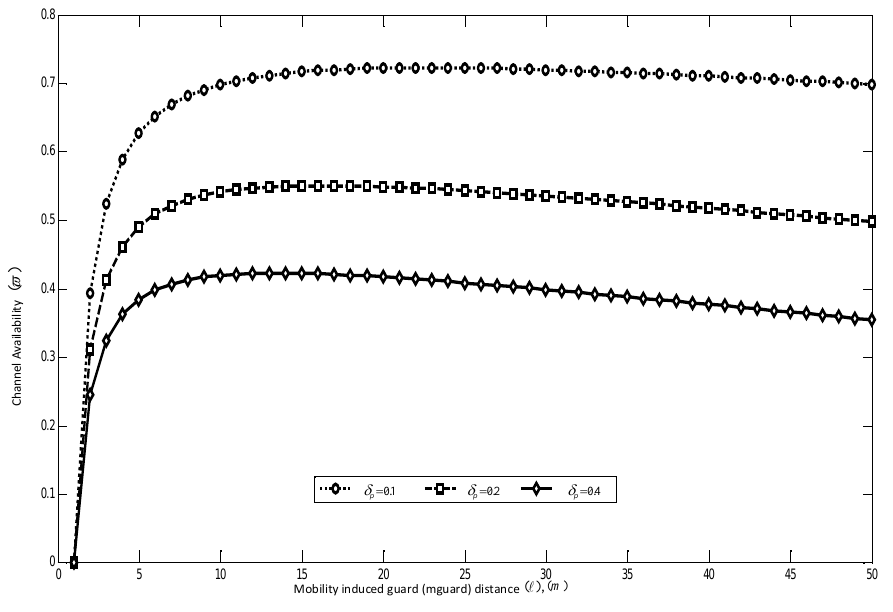
Figure 12. Mobility-induced spectrum availability in a cognitive radio sensor network